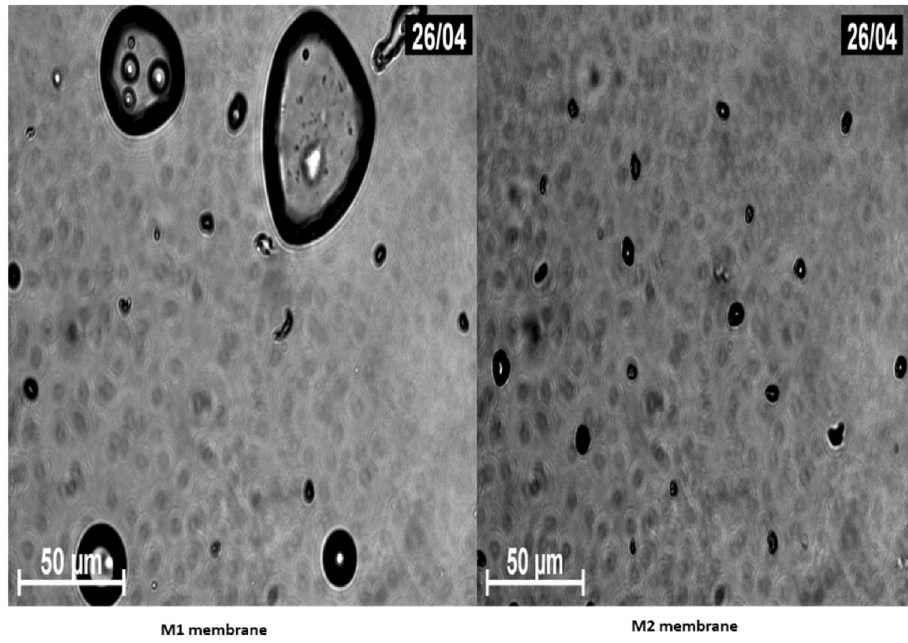
Figure 11. Microscopic analysis of the permeate after microfiltration for M1 and M2 membranes, in 0.6